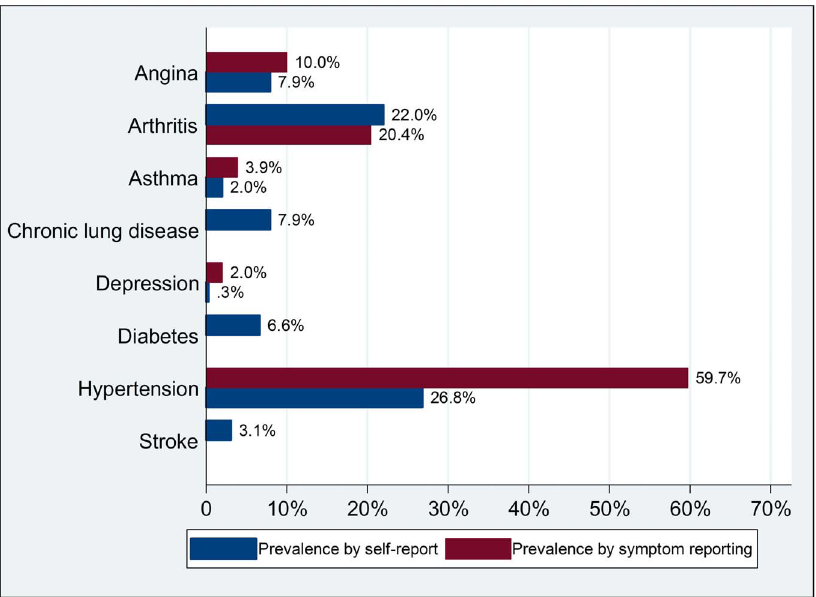
Figure 3. Prevalence of multiple chronic conditions by gender and age group. doi:10.1371/journal.pone.0074176.g003 PLOS ONE |